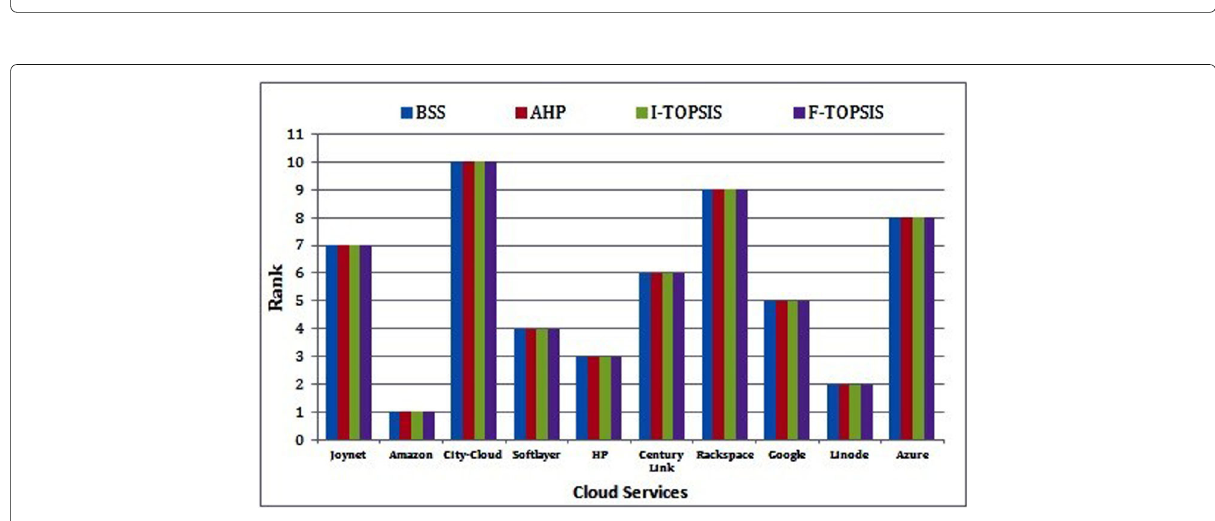
Fig. 4 Rank Analysis of All Cloud Services